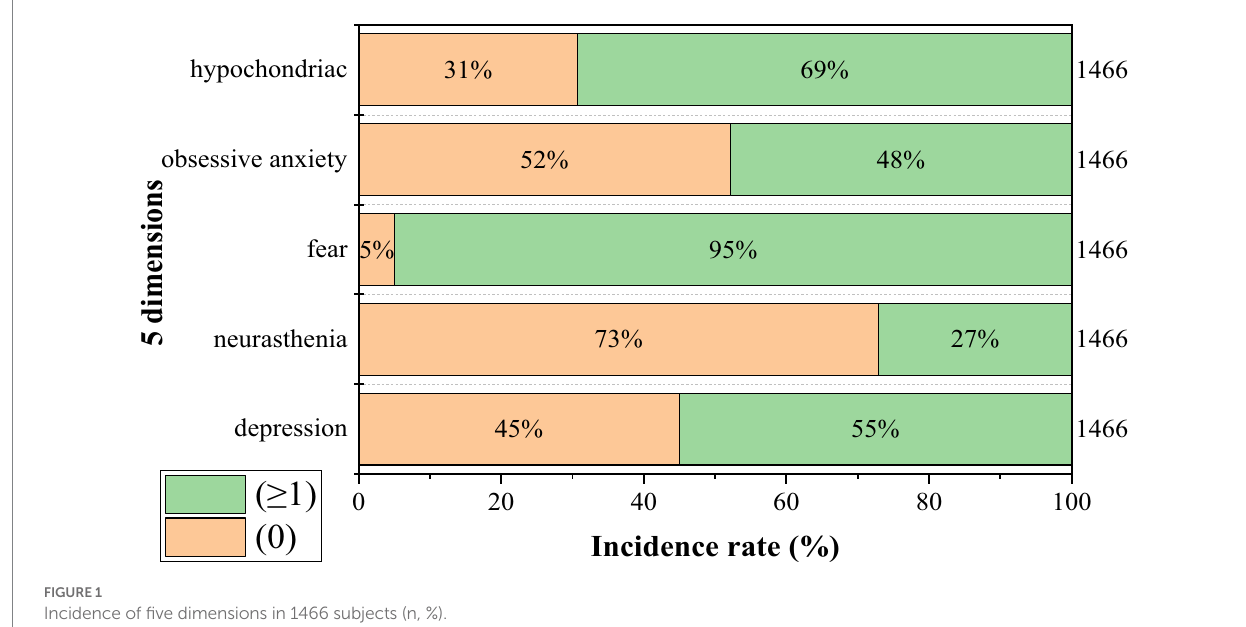
FIGURE 1 Incidence of five dimensions in 1466 subjects (n, %).